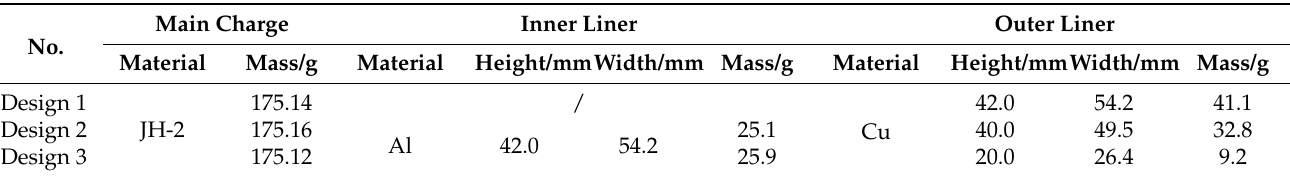
Table 1. Experimental conditions.